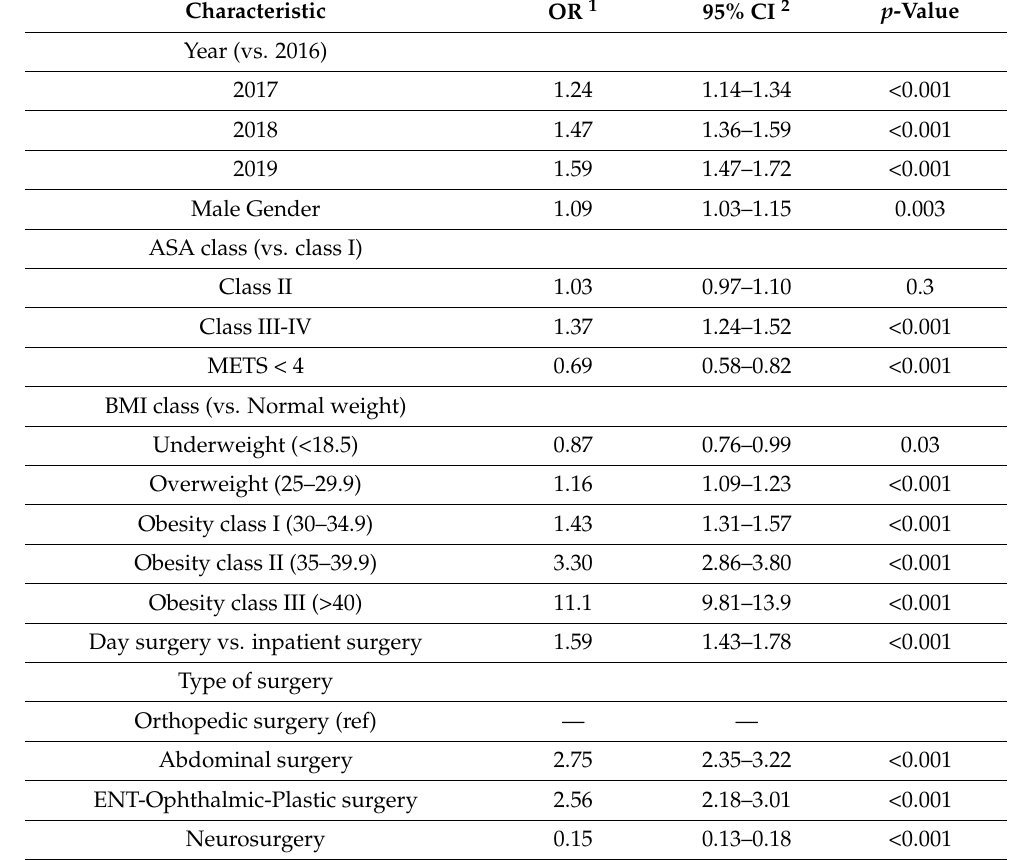
Table 3. Multivariable model to identify factors associated with NMBA